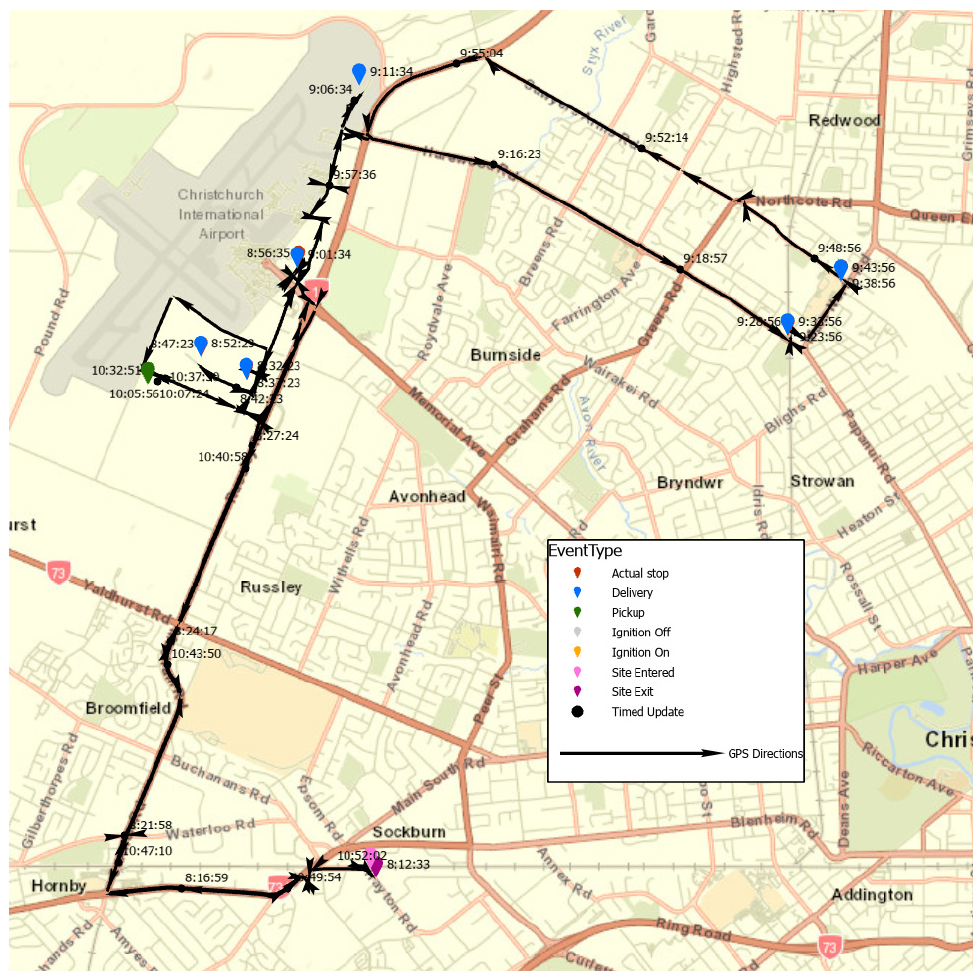
Figure 7. Truck actual route by